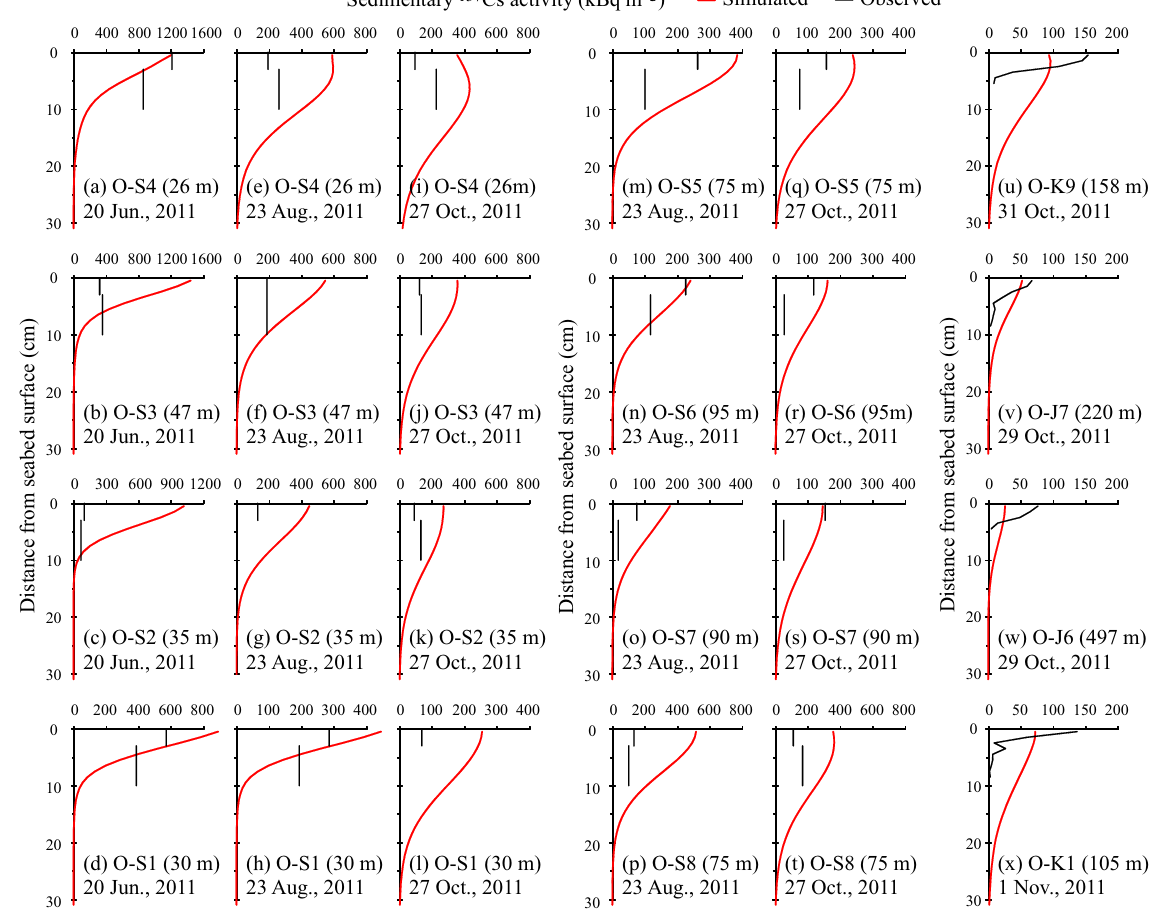
Figure 8. Comparison between simulated vertical sedimentary 137 Cs profiles (red lines) and observed (black lines) by (a–t) Otosaka and Kobayashi (2013) and (u–x) Otosaka and Kato (2014). Values in parentheses show observed water depth.